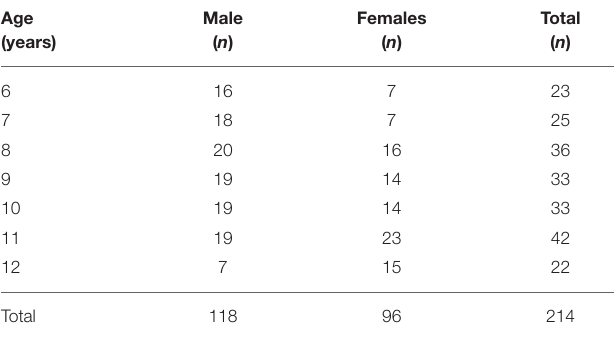
TABLE 1 | Demografic data by age and